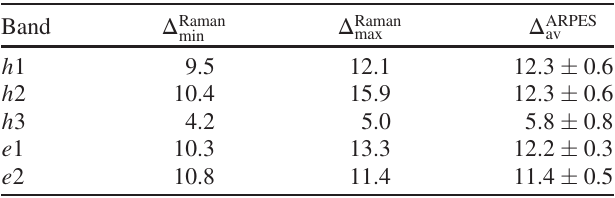
TABLE I. Gap energies (meV) as obtained by Raman scattering and the present analysis compared to those from ARPES (Ref. [61]). The bands h 1 – e 2 are color coded in Fig. 5 in Appendix A. Bands h 1 and h 2 cannot be distinguished in the ARPES experiment and therefore have the same